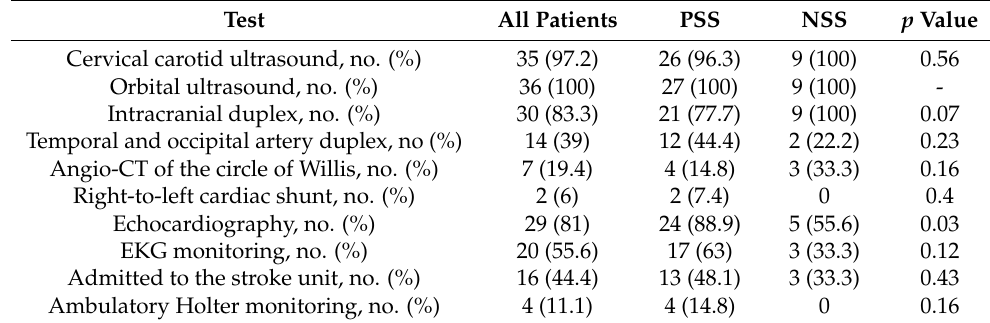
Table 2. Complementary